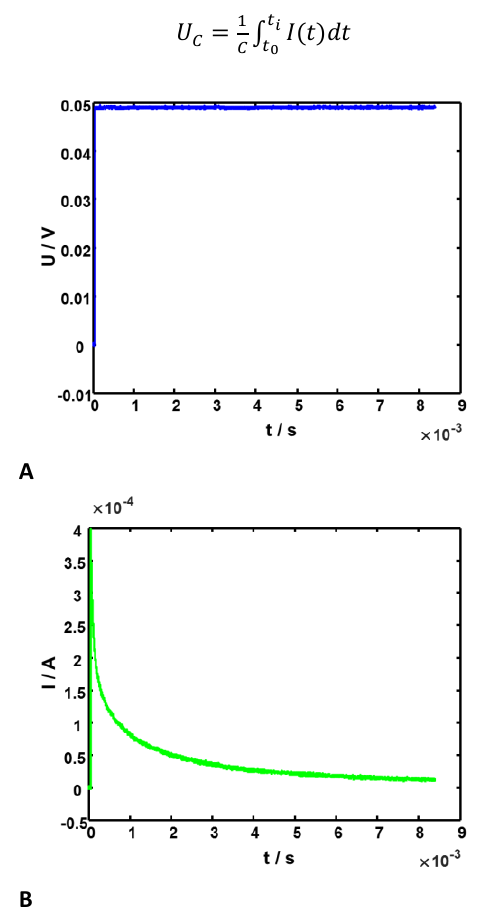
Fig. 1: Example of stimulus and response signals. A : Stimulus B : Step